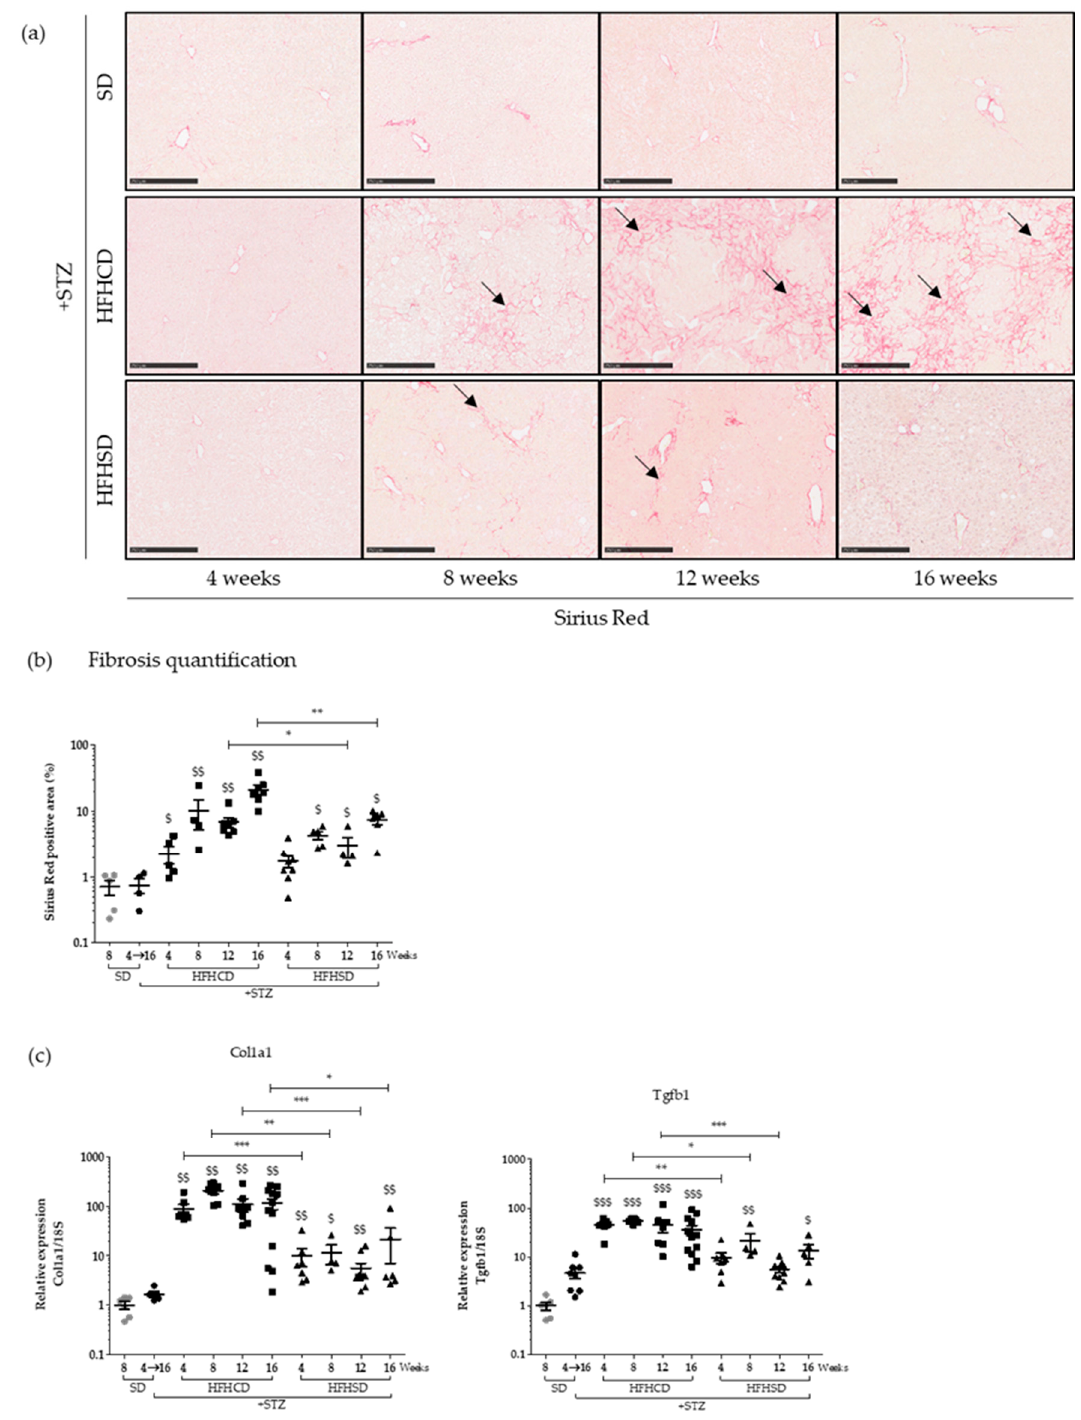
Figure 2. High-fat diet type a ff ected fibrosis progress in diabetic mice. Healthy or diabetic (STZ) C57Bl6 / J male mice were fed either a SD, a HFHCD or a HFHSD during 4, 8, 12 or 16 weeks. ( a ) Sirius Red staining of liver sections. Black arrows show collagen deposition. Scale bars: 250 µ m, original magnification × 100; ( b ) quantification of fibrosis as determined by the percentage of Sirius Red positive area and ( c ) hepatic mRNA expression levels of Col1a1 and Tgfb1 genes. For all graph, each grey dots, black dots, black squares and black triangles represent individuals from the di ff erent groups: healthy mice under SD, diabetic mice under SD, diabetic mice under HFHCD or HFHSD, respectively. $ p < 0.05; $$ p < 0.01 and $$$ p < 0.001 compared diabetic mice under HFHCD or HFHSD to diabetic mice under SD; * p < 0.05; ** p < 0.01 and *** p < 0.001 compared diabetic mice under HFHCD to diabetic mice under HFHSD at the same time